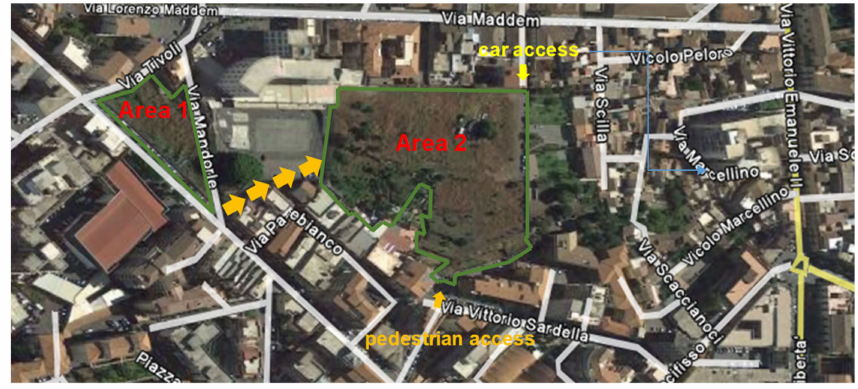
Figure 4. Location of Areas 1 and 2.